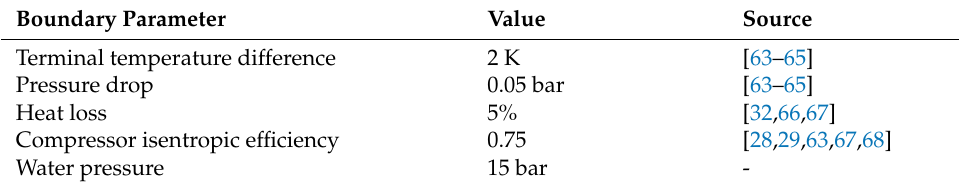
Table 1. Description of all boundary and internal conditions of the